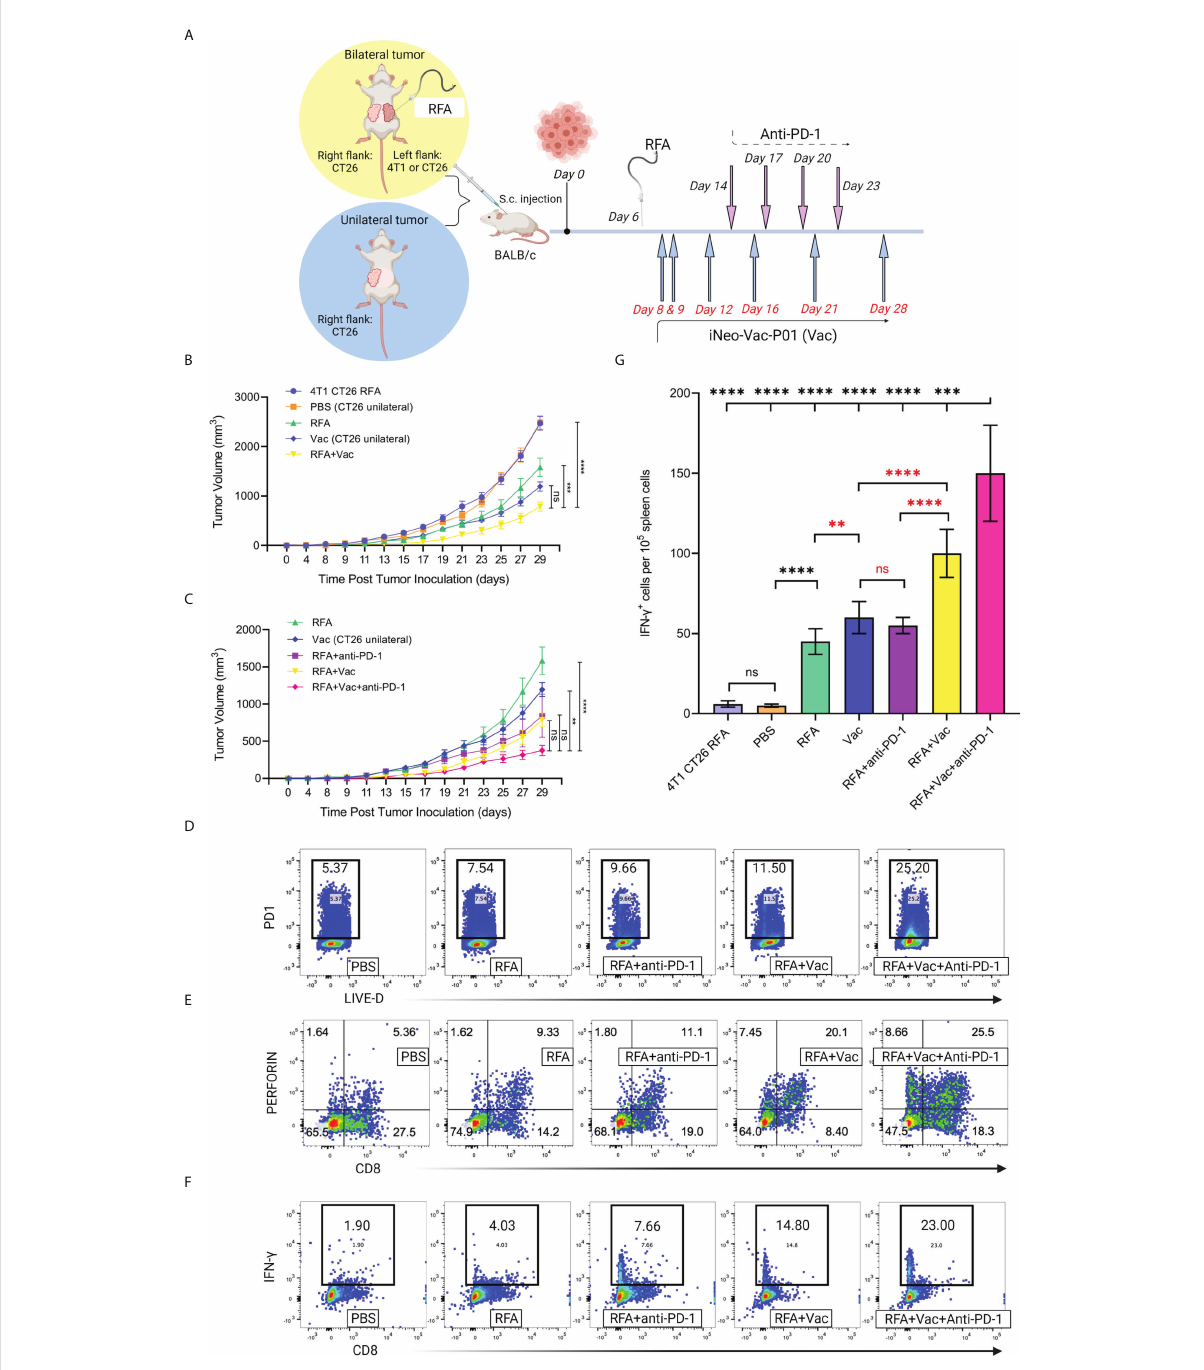
FIGURE 5 Combination treatment of RFA and neoantigen vaccination inhibited tumor growth and elicited robust local and systemic antitumor immune responses in mice. (A) Schematic illustration of the treatment mice received. Mouse models with unilateral or bilateral tumor(s) were established; mice with bilateral tumors received RFA treatment on the left fl ank tumor. (B, C) Tumor growth of mice receiving different treatments. Ablation of an irrelevant tumor (4T1) did not help inhibit the growth of CT26 tumor. Combinational use of RFA and iNeo-Vac-P01 (RFA+Vac) signi fi cantly slowed down the growth of CT26 tumor, and the inclusion of anti-PD-1 further enhanced this antitumor effect. (D) Flow cytometric analyses of PD-1 expression in tumor tissues (n=3). (E) Flow cytometric analyses of multifunctional T cells, gating on CD8 + perforin + cells (n=3). (F) Flow cytometric analyses of cytotoxic T cells, gating on CD8 + IFN- g + cells (n=3). (G) Ex vivo ELISpot assay. Spleen cells were collected and re-stimulated by neoantigen peptides. Data shown in Mean ± SD; two-tailed p value was obtained through unpaired t test. ns, not signi fi cant (p > 0.05); **p ≤ 0.01; ***p ≤ 0.001; ****p ≤